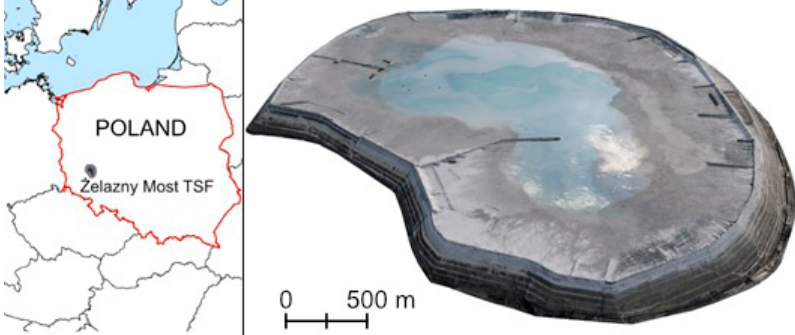
Figure 1. Location ( left ) and 3-D visualisation ( right ) of Ż elazny Most tailings storage facility (TSF), Poland.